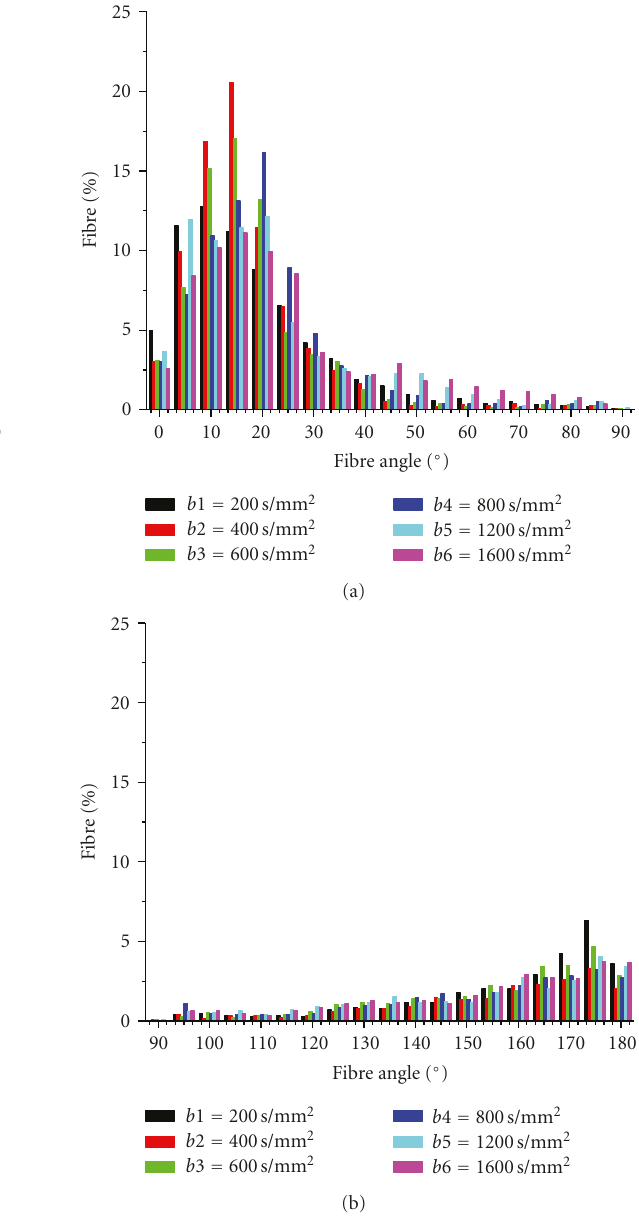
Figure 7: Histogram representing the fibre angle distribution for di ff erent b values. For ease of representation it has been split into two graphs: (a) 0 ◦ to 90 ◦ ; (b) 90 ◦ to 180 ◦ . The angles are evaluated over bands of 5 ◦ and centered in the middle of each